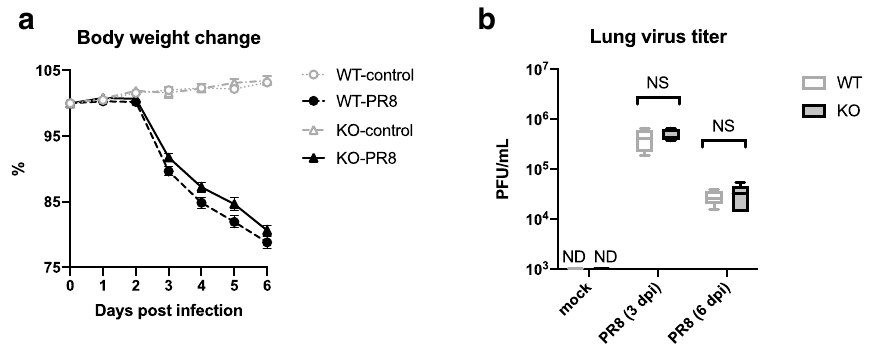
Figure 3. Effect of OLR1 on virus infection-induced body weight decrease and lung viral replication. WT and KO mice were intranasally inoculated with PBS control or PBS comprising PR8 virus, and ( a ) body weight change and ( b ) lung virus titers were evaluated. ( a ) The body weight change of mice was calculated as a percentage of the original weight. Symbols represent mean ± SEM (WT-control, n = 9; WT-PR8, n = 9; KO-control, n = 6; KO-PR8, n = 8). Circles and triangles indicate data from WT and KO mice, respectively. Open and closed symbols indicate PBS control and PR8 virus-infected mice, respectively. No significant difference was detected between WT and KO mice at each time point by two-way ANOVA. ( b ) At 3 and 6 dpi, mice were euthanized for the collection of lung samples, and plaque assays on MDCK cells were performed to calculate the lung viral titers in each sample (n = 5). Values are represented by box-and-whiskers plots as follows: the central line in the box is the median, the bottom and top lines of the box are the first and third quartiles, respectively, whiskers are the minimum to maximum values. White and gray boxes indicate data from WT and KO mice, respectively. No significant difference was detected between WT and KO mice in each treatment group by two- way ANOVA. ( a and b ) PR8, influenza virus A/Puerto Rico/8/34; PFU, plaque-forming unit; dpi, days post- infection; WT, wild type mice; KO, Olr1 knockout mice; ND, not detected; NS, not significant.